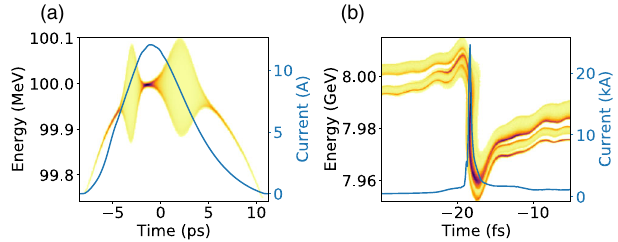
FIG. 10. (a) The same two laser pulses, as in Fig. 2, heats all but a 2-ps slice of the electron beam after the laser heater, but the baseline laser heater – induced energy spread for the cold core beamlet is reduced to 2 keV rms. (b) The longitudinal phase space right before the undulators shows a 20 kA, 0.2-fs short current spike.